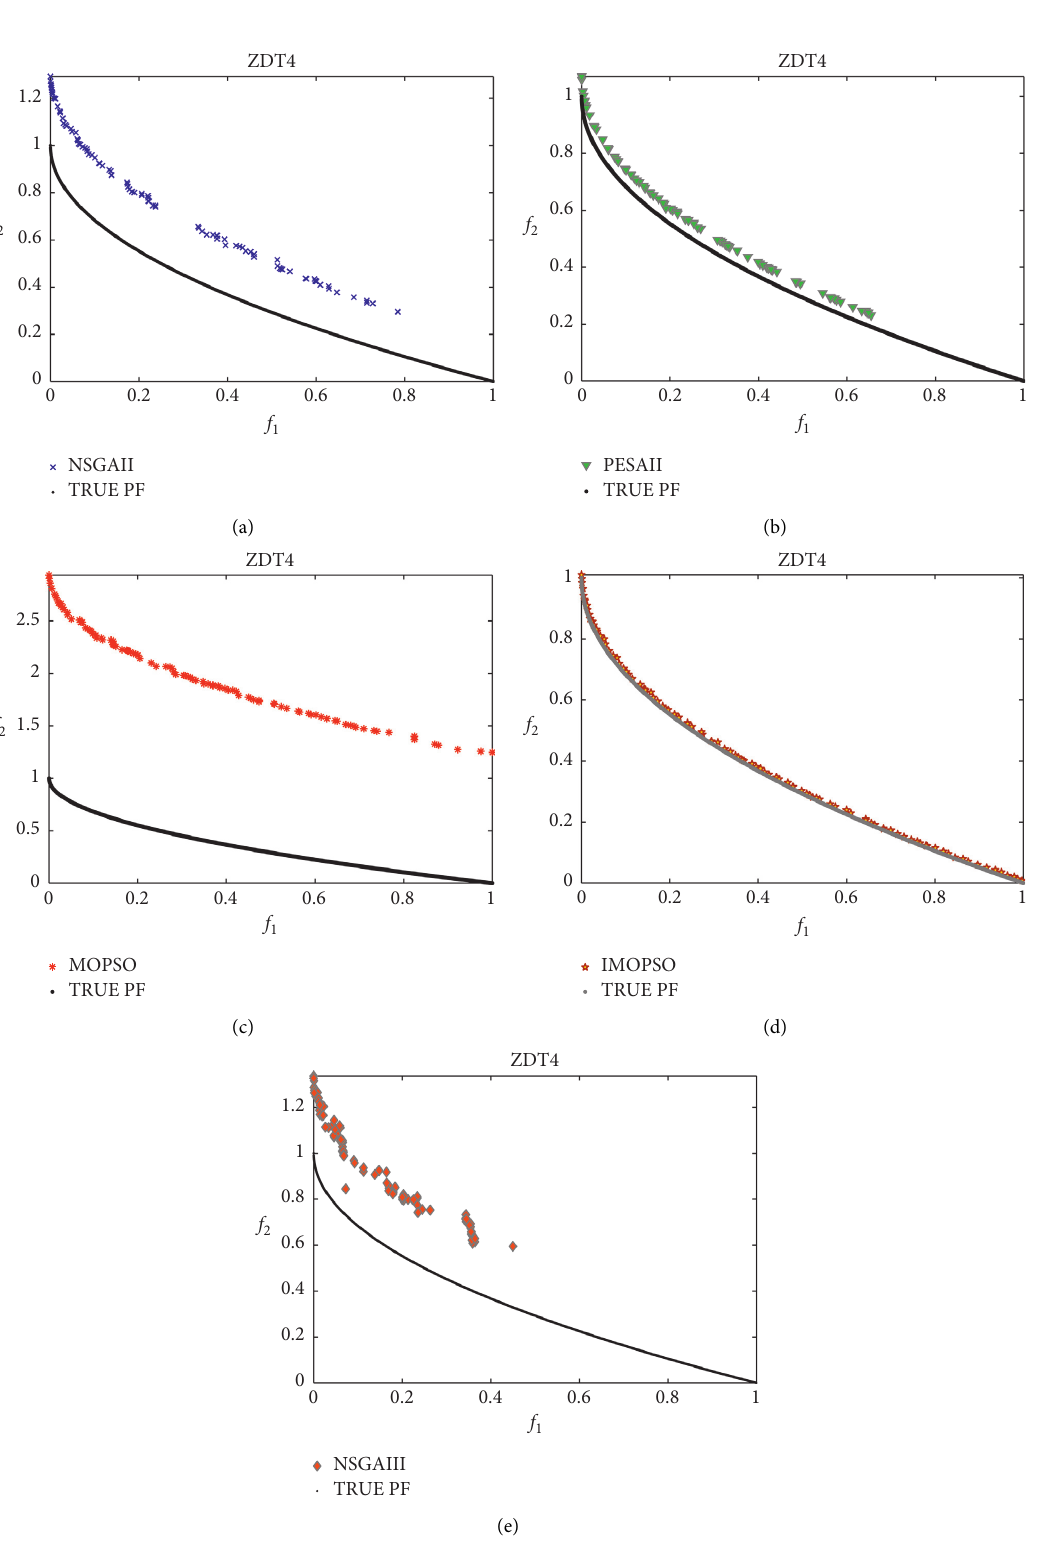
Figure 5: ZDT4 test